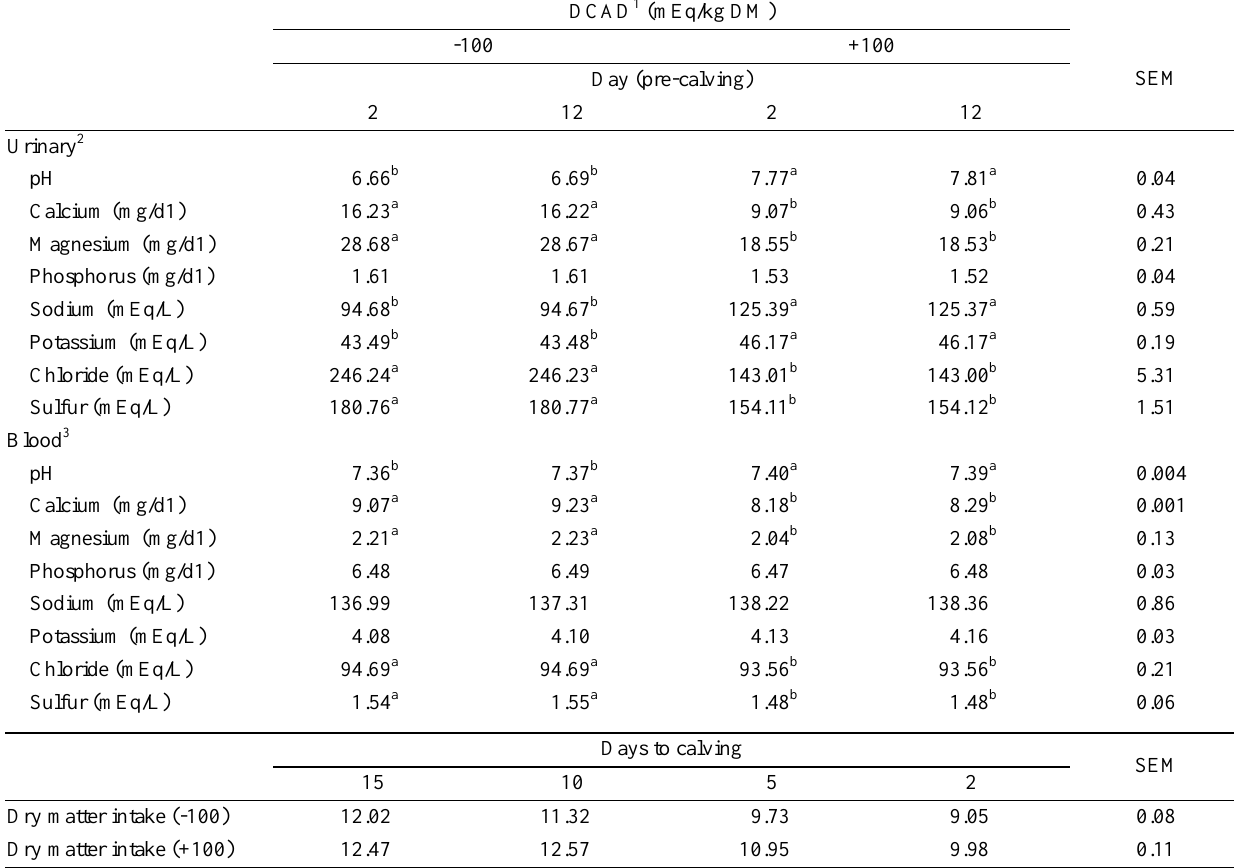
Table 2. The effects of DCAD on fluid acid-base balance, plasma and urinary mineral concentrations and DMI in periparturient dairy cows